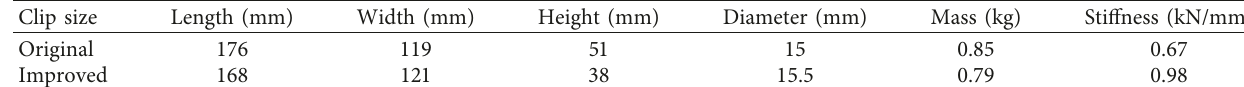
Table 5: Design parameters of the ω -type rail clip before and after improvement.